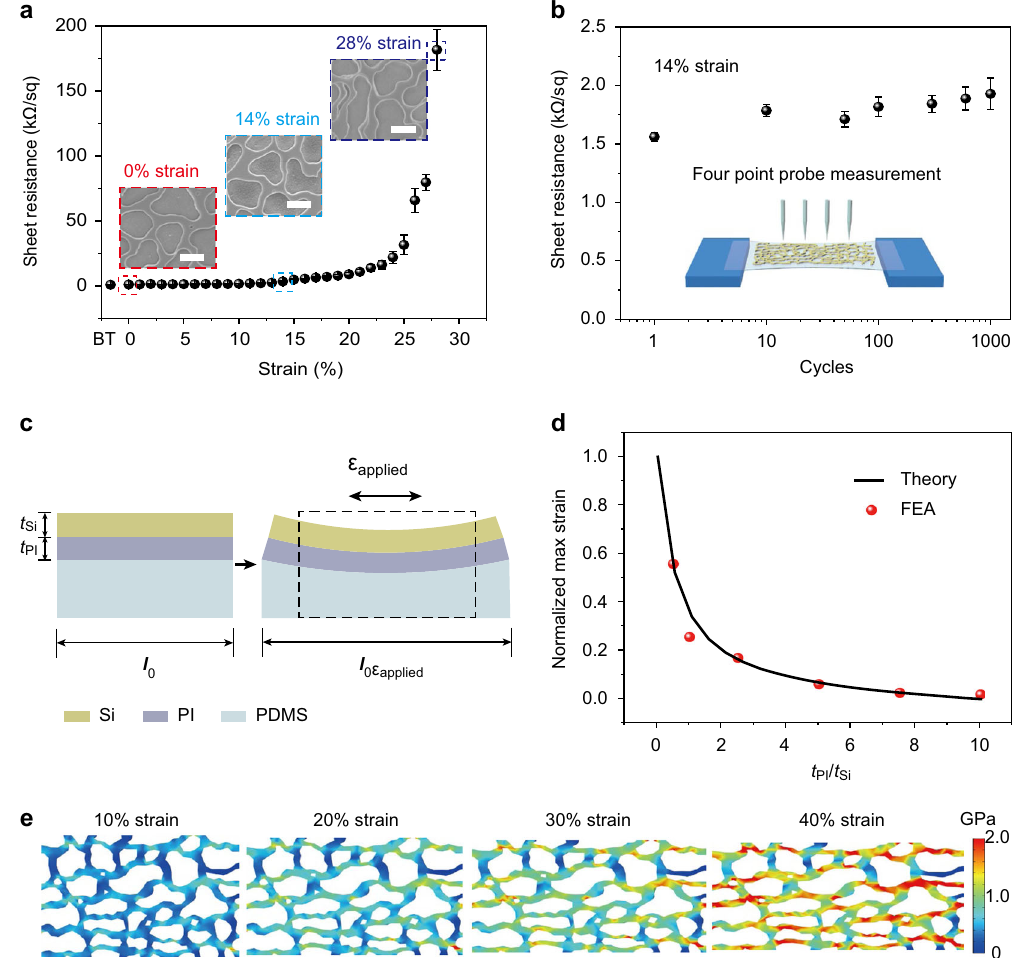
Fig. 4 Stretchability modeling of Si nanomeshes. a Sheet resistance of a bilayer nanomesh fi lm with 33.7% fi ll factor as a function of tensile strain. BT means before transfer. SEM images (inset) of zero, 14 and 28% strain states, showing the microscale stretching behavior of the nanomeshes. The scale bar is 1 μ m. b Change in sheet resistance versus stretching cycles (up to 1000 cycles) of a bilayer nanomesh fi lm (33.7% fi ll factor). c Schematic mechanics model of the PI/Si bilayer structure on an in fi nitely thick and soft PDMS substrate. An applied strain extends the bottom of the PI layer from the original length of l 0 to the deformed length of l 0 ε applied . d The normalized maximum strain ε max / ε max0 in the Si layer vs the normalized PI layer thickness, as predicted by FEA (dots) and Eq. (3) (solid line). e FEA simulation of stress distribution in a PI/Si nanomesh fi lm at 10%, 20%, 30%, and 40% strain state,